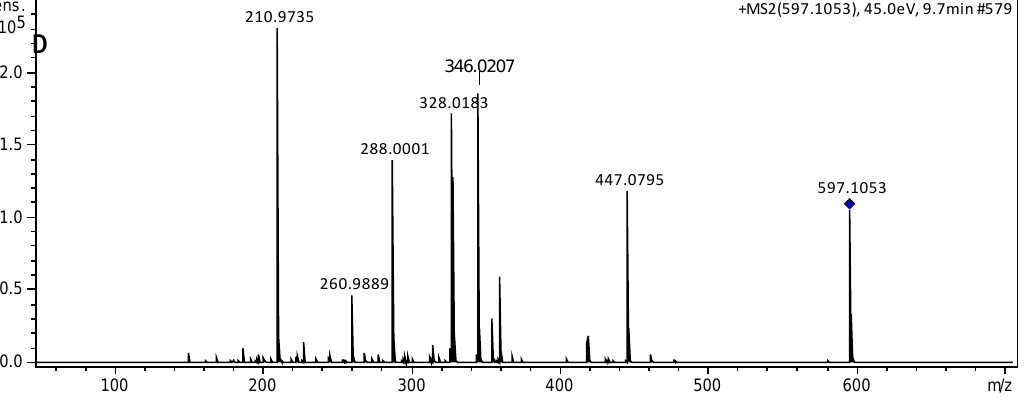
Figure 1. Electrospray ionization (ESI) mass spectra of cobalt(III) complexes 1 and 2 . ( A ) (+)-high-resolution electrospray ionization mass spectra (HRESIMS) spectrum of 1 , m/z 473.0734 [M] + (calcd. for C 18 H 22 CoN 8 S 2 , 473.0735, Δ – 0.21 ppm); ( B ) (+)-HRESIMS spectrum of 2 , m/z 597.1049 [M] + (calcd. for C 28 H 26 CoN 8 S 2 , 597.1048, Δ 0.17 ppm); ( C ) ESI – MS/MS spectrum of the molecular ion m/z 473.0733; and ( D ) ESI – MS/MS spectrum of the molecular ion m/z 597.1053. The charged complex ions were observed at m/z 473.0734 [M] + ( 1 ) and 597.1049 [M] + ( 2 ), in agreement with calculated values for C 18 H 22 CoN 8 S 2 (473.0735; Δ − 0.21 ppm) and C 28 H 26 CoN 8 S 2 ( 597.1048; Δ 0.17 ppm) , respectively. Collision-induced dissociation (CID) experiments (MS/MS) with